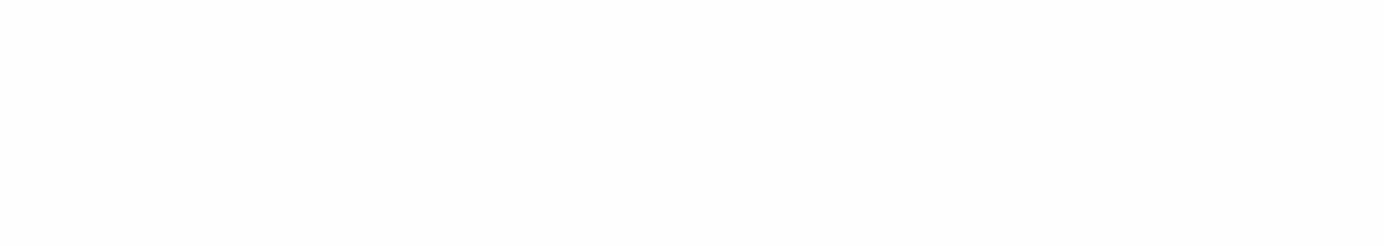
FIGURE 3 Ratio of number of external forcing pulses to the number of heart beats during 250s versus frequency detuning between forcing and